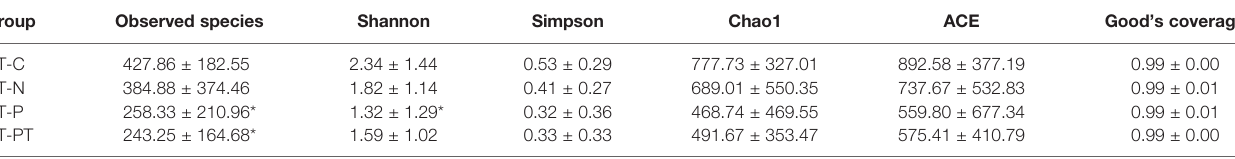
TABLE 2 | Alpha-diversity index for each group. Group